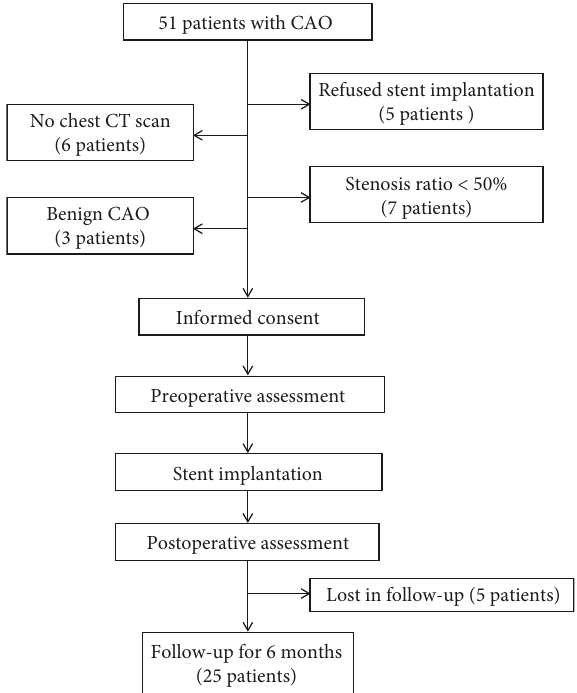
Figure 2: The clinical trail protocol